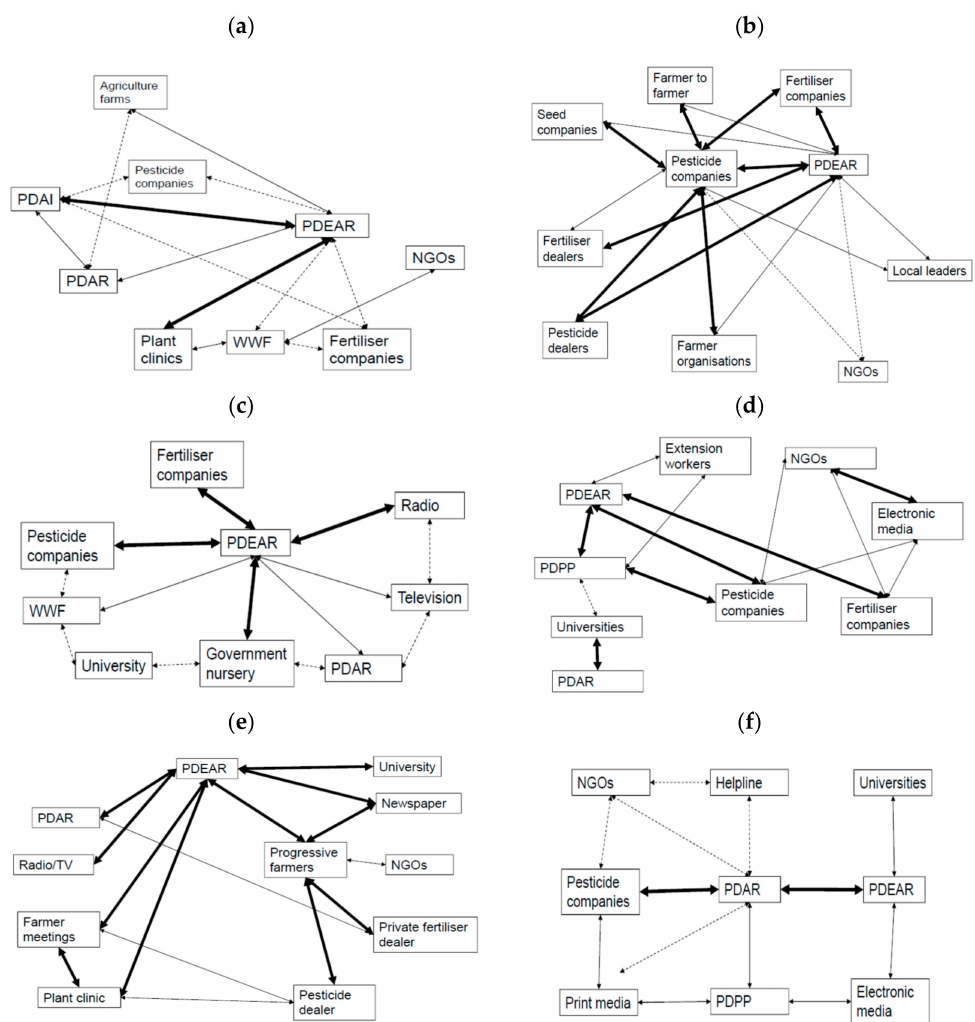
Figure 1. Rural advisory services’ systems visualisations from a PW and non-PW district